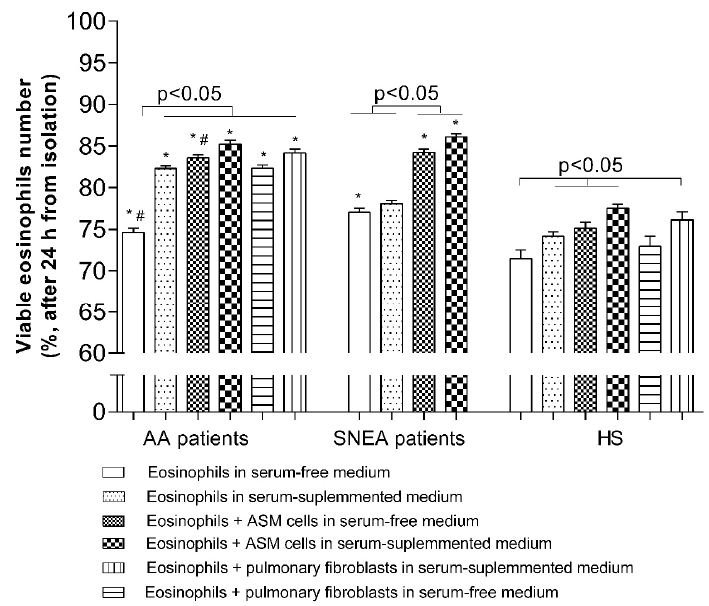
Figure 5. Eosinophil viability. Changes in the number of viable eosinophils during different incubation conditions. Results from independent experiments of AA— n = 14, HS— n = 15, SNEA— n = 10;